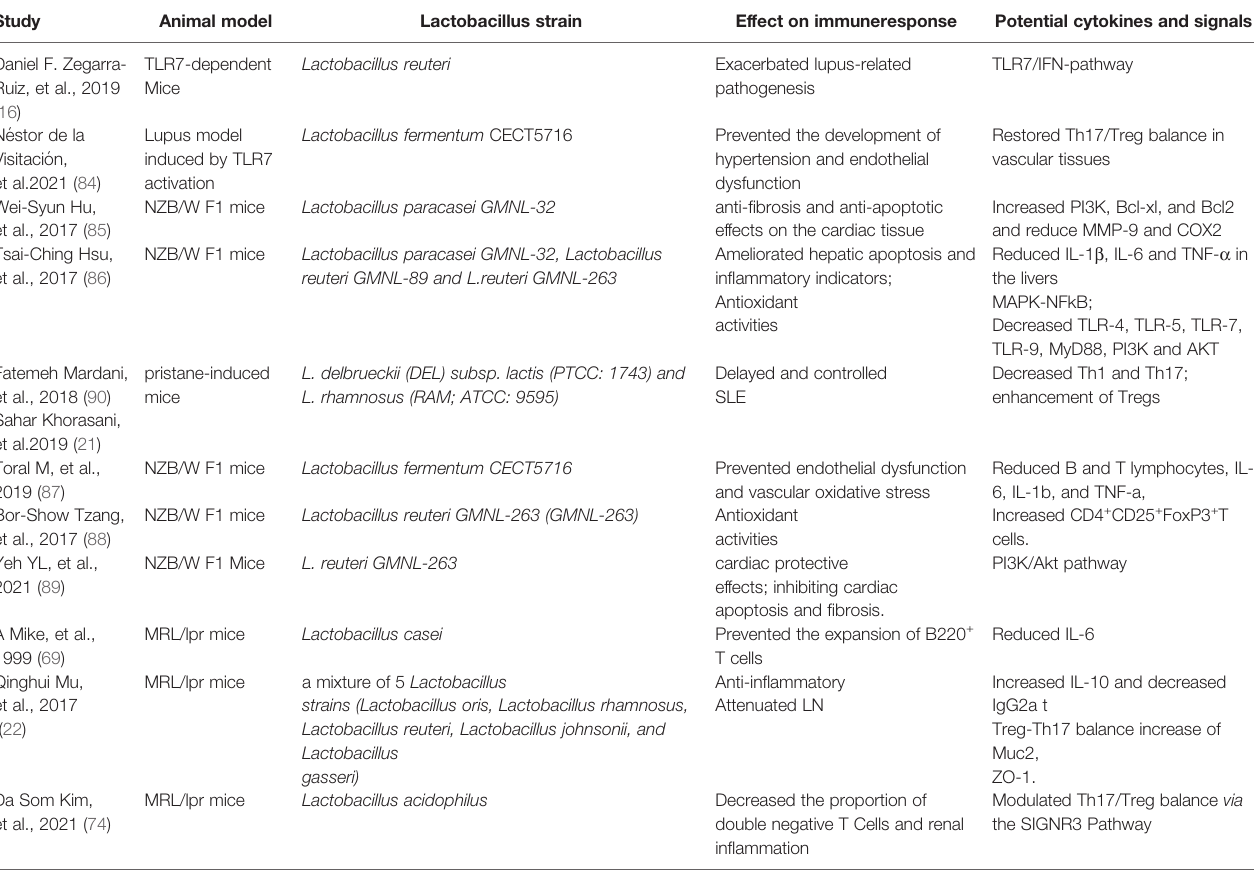
TABLE 2 | Studies investigating the Lactobacillus in murine lupus.